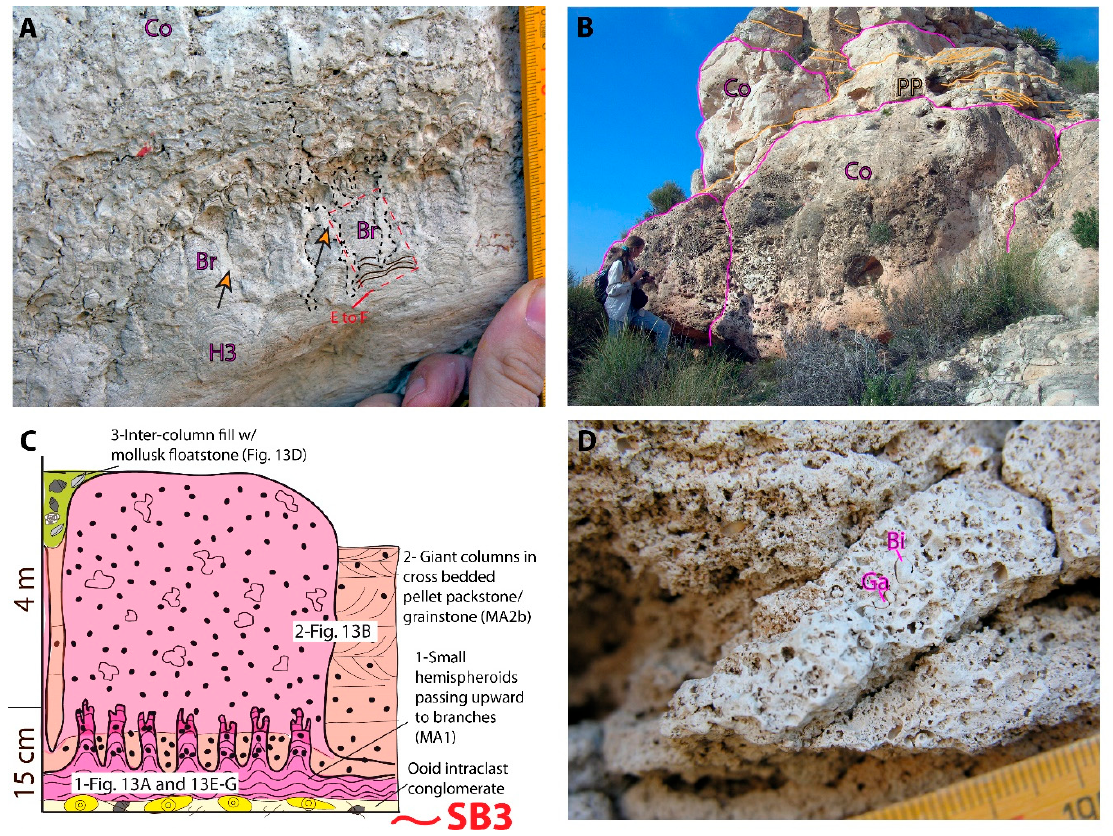
Figure 13. Cont Figure 13. Cont.